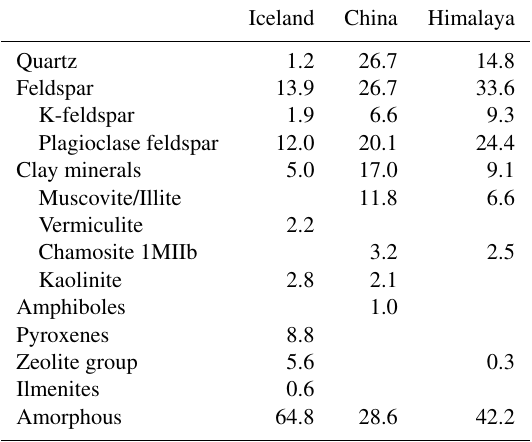
Table 1. Mineralogical composition of each untreated dust ex- pressed in percent weight. Included in the table are various impor- tant mineralogical groups, calculated as sums of the corresponding